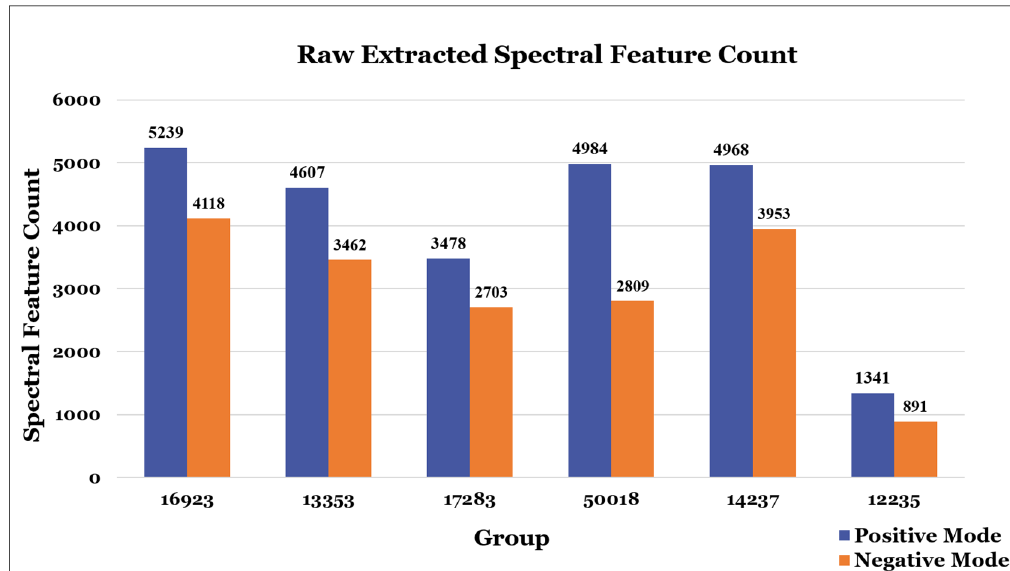
Figure 5. Degree of overlap for all extracted spectral features. The graph shows the total number of overlapping features found between the full extracted list of spectral features from 6 of the participants that provided raw data. More overlap was observed in the negative mode data compared to positive mode data.